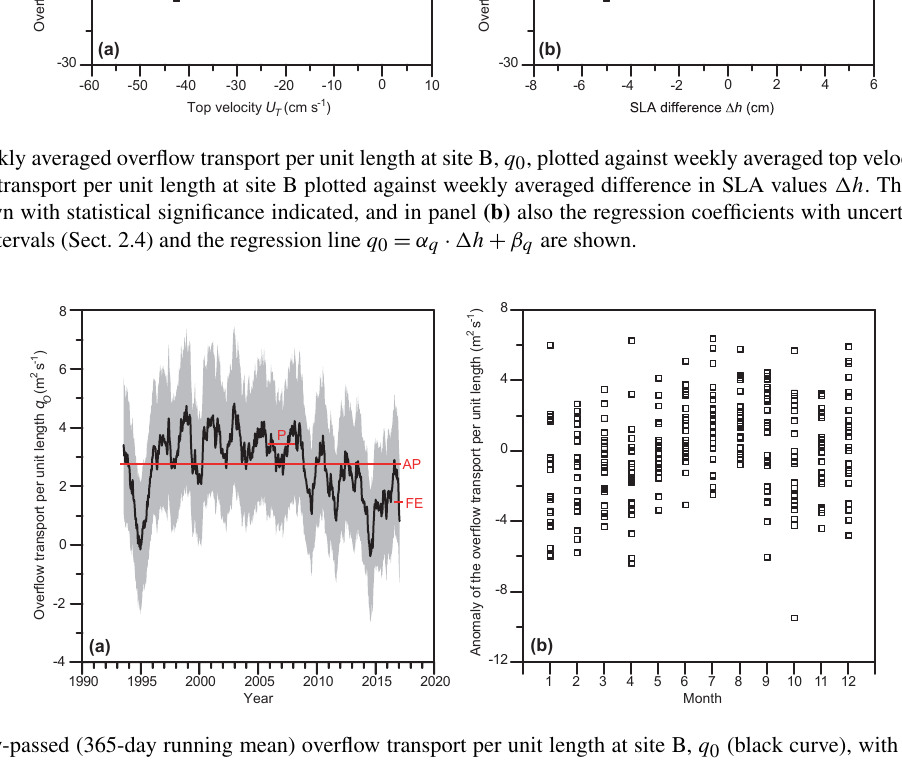
Figure 14. (a) Low-passed (365-day running mean) overflow transport per unit length at site B, q 0 (black curve), with uncertainty interval (grey area) from 1993 to 2016 based on satellite altimetry and the regression equation in Fig. 13b. Red lines indicate the estimated overflow transport per unit length averaged over the field experiment (FE), the whole altimetry period (AP) and the duration of the ADCP measure- ments at site P (P). (b) Monthly averages of the anomaly of the overflow transport per unit length, defined as the deviation from the 365-day running mean centred on the